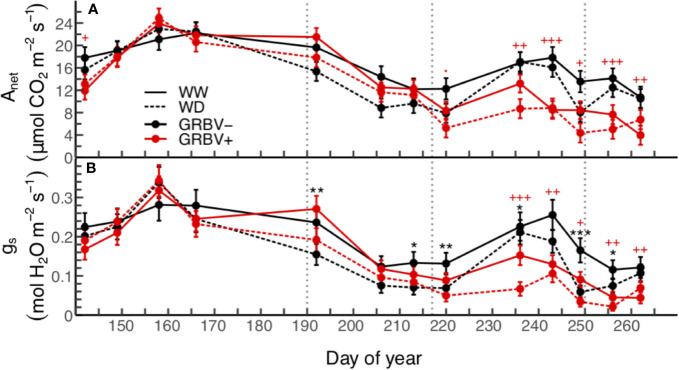
Season-long responses of net carbon assimilation (A) and stomatal conductance (B) to irrigation treatments and virus status in 2018. Data are means ± 1 standard error (n = 5). Symbols ‘.’, ‘*,’ ‘**’, and ‘***’ represent statistical significance at p < 0.10, 0.05, 0.01, and 0.001, respectively, for well-watered (WW) versus water deficit (WD), and likewise, symbols '.', '+', '++', and '+++' are respective to those p-values for GRBV- versus GRBV+. Vertical dotted lines in represent dates of treatment imposition, veraison, and harvest, from left to right, respectively.